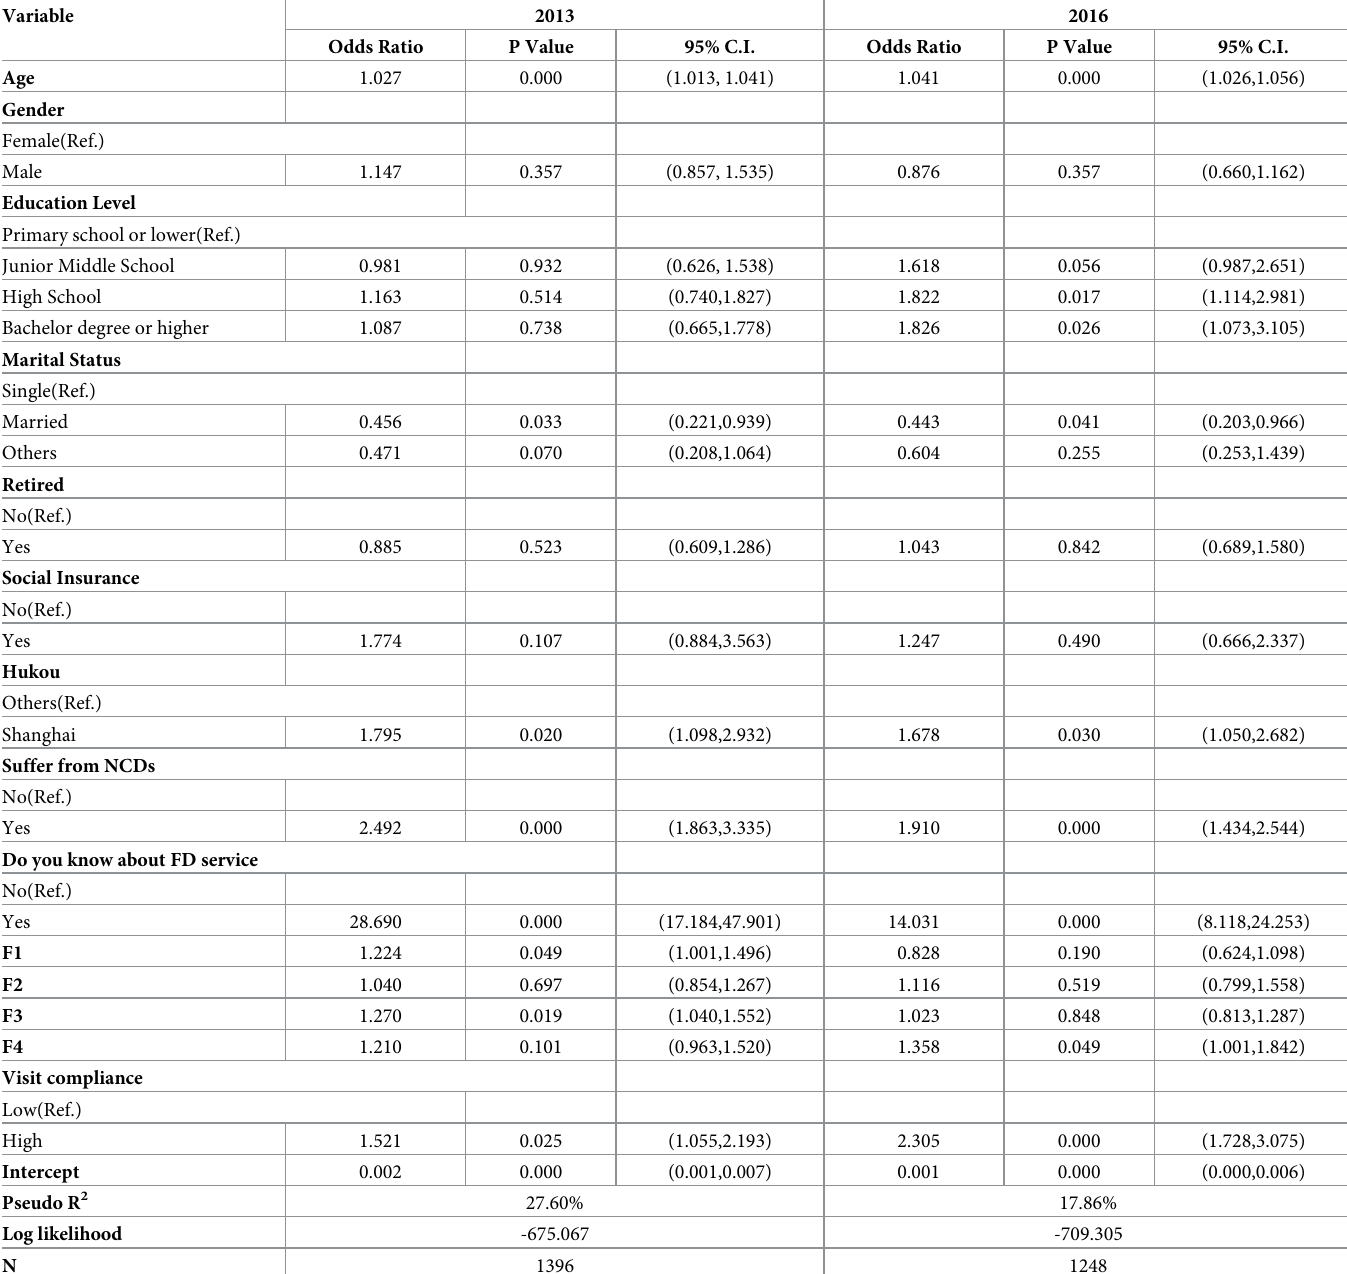
Table 5. Multivariate analysis of residents’ contract behavior in 2013 and